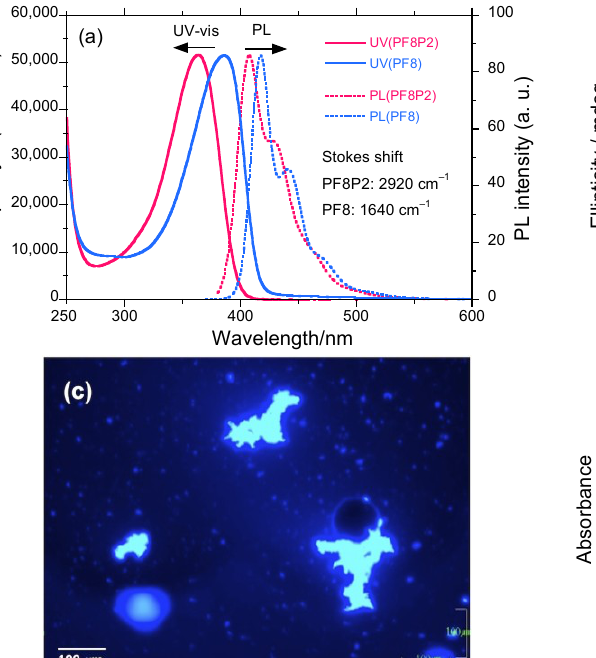
Figure 2. ( a ) The UV-vis absorption (1.0 × 10 −5 mol L −1 ) and PL spectra (excited at 360 nm, 1.0 × 10 −7 mol L −1 ) of PF8P2 in chloroform (red solid and dotted lines), and for comparison, normalized UV-vis (ca. 2 × 10 −5 mol L −1 ) and PL (excited at 360 nm, 1 × 10 −7 mol L −1 ) spectra of PF8 in chloroform (blue solid and dotted lines). ( b ) The CD and UV-vis spectra (1.0 × 10 −5 mol L −1 ) of PF8P2 in chloroform/( R )-limonene (0.3/2.7 (v/v)) at 25 °C. ( c ) PL image (excited at 365 nm) of PF8P2 aggregates produced in chloroform/limonene/methanol (0.3/1.1/1.6 (v/v/v)). Scale bar: 100  m. ( d ) The red-shifted UV-vis spectra of PF8P2 due to aggregation in chloroform/( R )-limonene/methanol (0.3/1.1/1.6